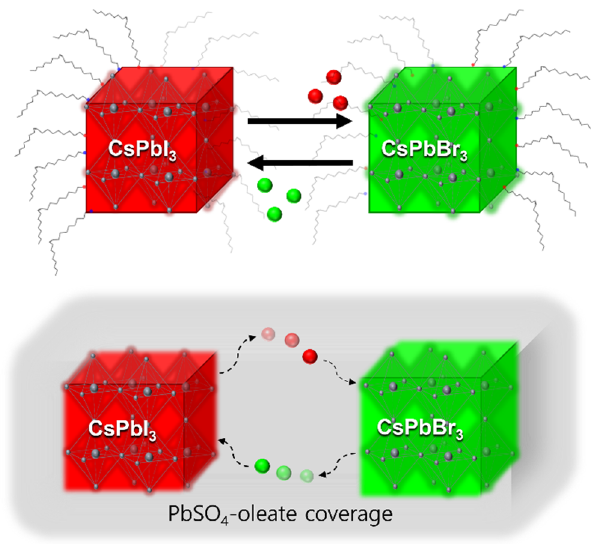
Table S1: Obtained Urbach energies; Table S2: Halide exchange reaction rate constants according to temperature and PbSO 4 -oleate reaction